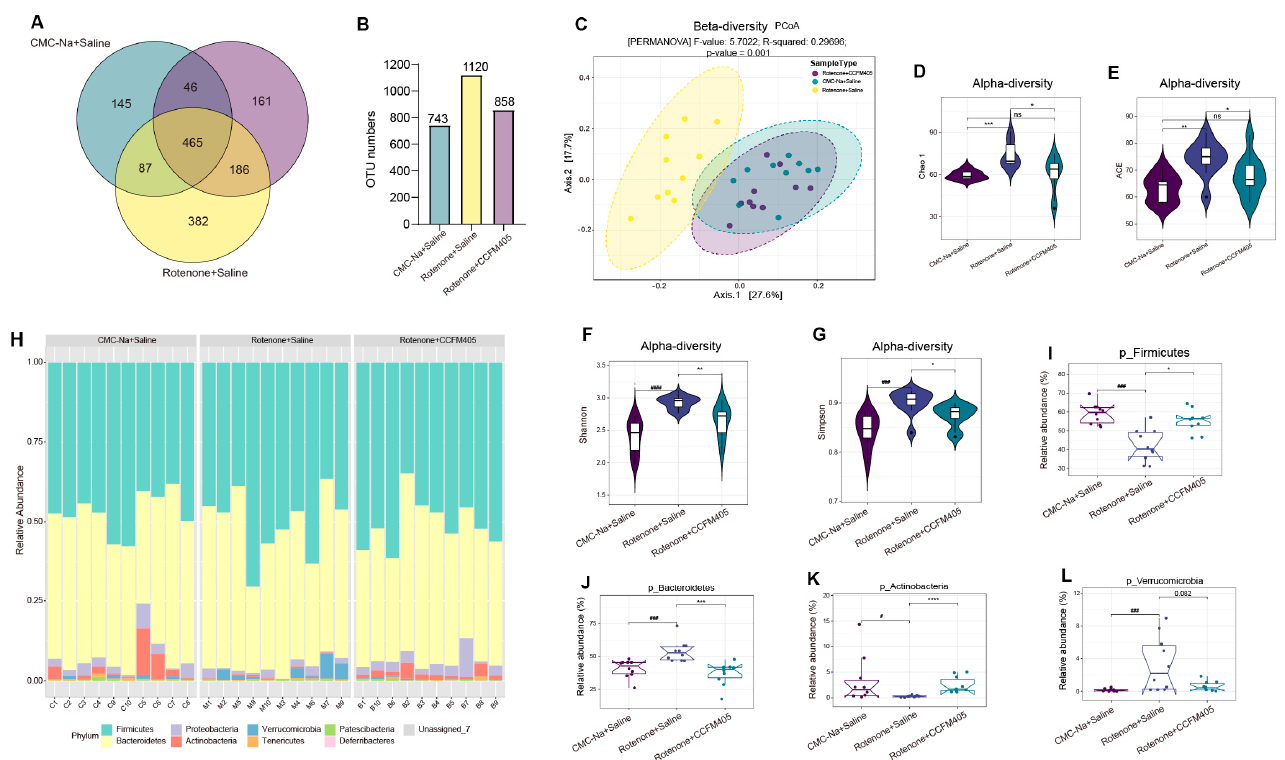
Figure 6. The effect of L. plantarum CCFM405 on gut microbiota diversity and its distribution at the phylum level. ( A ) A Venn diagram was utilized to illustrate the discrepancy in operational taxonomic units (OTUs) between the three groups; ( B ) Total number of OTUs in each group; ( C ) β -diversity measured by PCoA. PERMANOVA on the Bray–Curtis dissimilarity index: F-value = 5.7022, R 2 = 0.29696, p -value = 0.001; ( D – G ) α -diversity indices reflected by the Chao1, ACE, Shannon, and Fisher index. Kruskal–Wallis tests calculated p -values; ( H ) the relative abundance of gut microbiota at the phylum level for each mouse is shown using stacked column bar graphs; ( I – L ) Mann–Whitney/Kruskal–Wallis tests/zero-inflated Gaussian fit model was used to conduct classical univariate statistical comparisons among selected phylum measured. Significance was considered for adjusted p (FDR, false discovery rate) < 0.05. n = 10/group. # p < 0.05, ### p < 0.001, #### p < 0.0001 signs Rotenone+Saline group vs. CMC-Na+Saline group; * p < 0.05, ** p < 0.01, *** p < 0.001, **** p < 0.0001 signs Rote-none+CCFM405 group vs. Rotenone+Saline group. “ns” means there was no noticeable difference between the